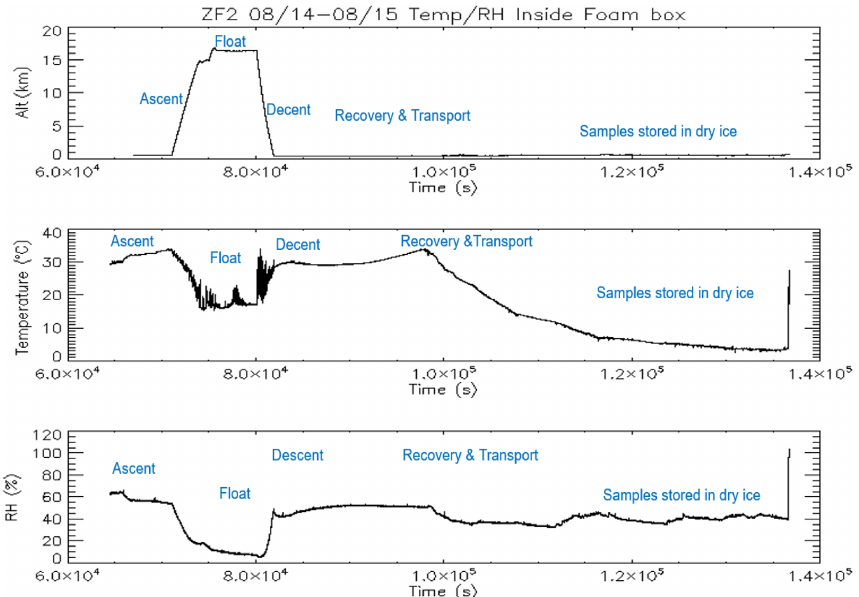
Figure 2. Time series of the altitude, temperature, and relative humidity profiles of the samples inside the foam box during the ZF2